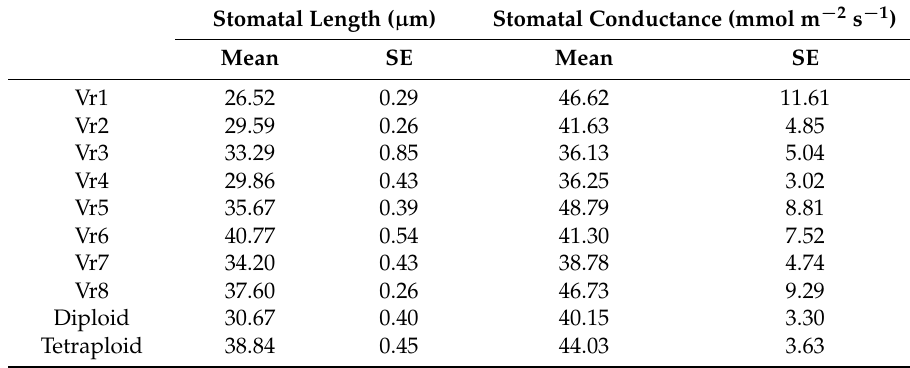
Table 2. Mean ± standard error (SE) stomatal size and conductance for each variety (Vr) and ploidy